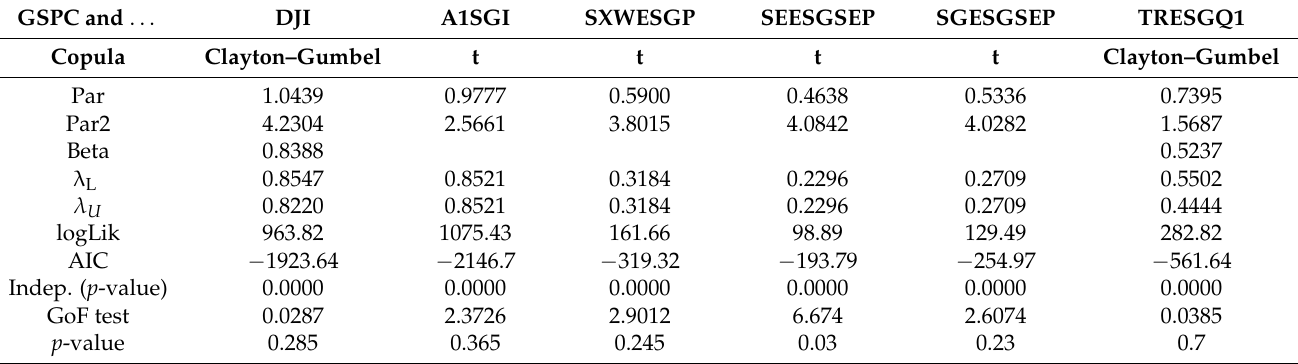
Figure 6. Kendall’s τ and copulas, 3 June 2014–31 January 2017. Table 8. Dependence structure for the GSPC and ESG indices, 3 June 2014–31 January 2017.